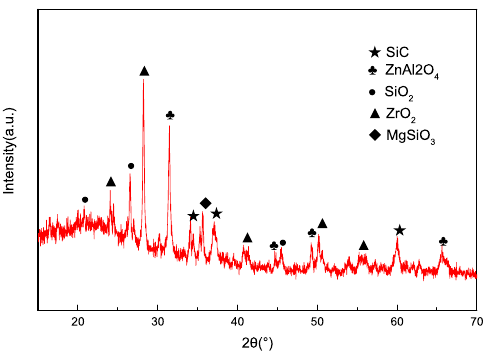
Figure 7: XRD spectrum of composites.